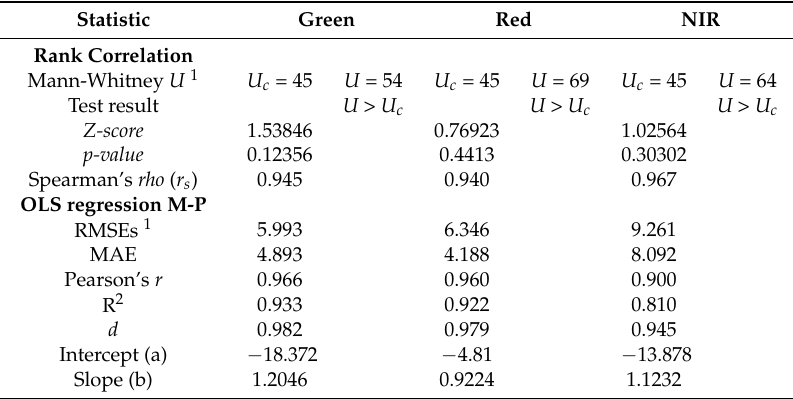
Table 16. Rank correlation and OLS regression statistics M-P from Table 15 data.